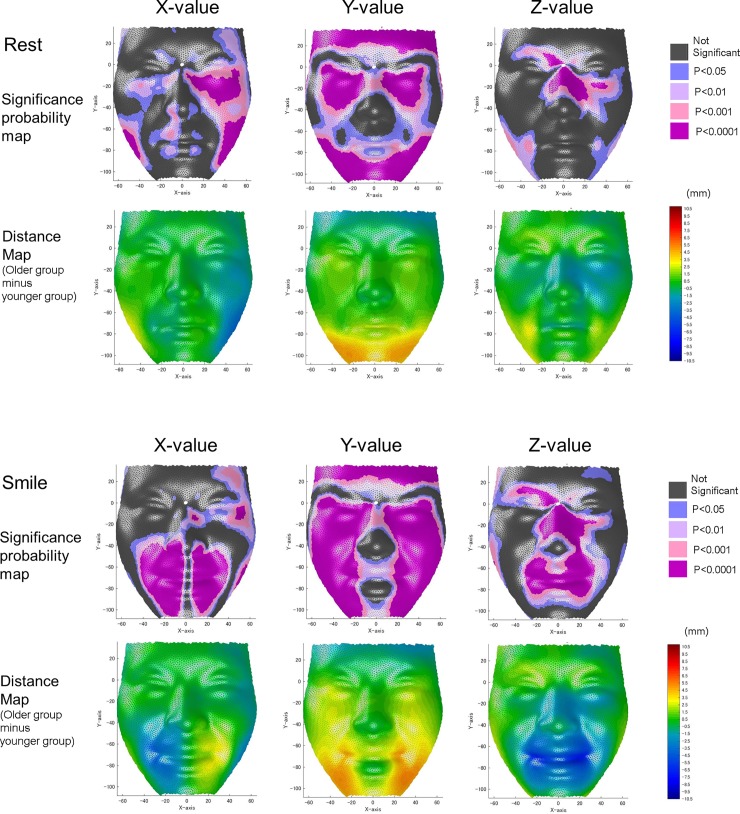
Significance maps [top (at rest) and second from the bottom (at peak
of smiling)] and difference maps [younger minus older; second from the
top (at rest) and bottom (at peak of smiling)].For the significance maps, blue designates P ≤ 0.05; pale pink, P ≤ 0.01;
dark pink, P ≤ 0.001; and purple, P ≤ 0.0001. For the difference maps,
red indicates that the younger group exhibited greater values than the
older group, whereas blue indicates that the older group exhibited
greater values than the younger group. Differences are represented in
mm.